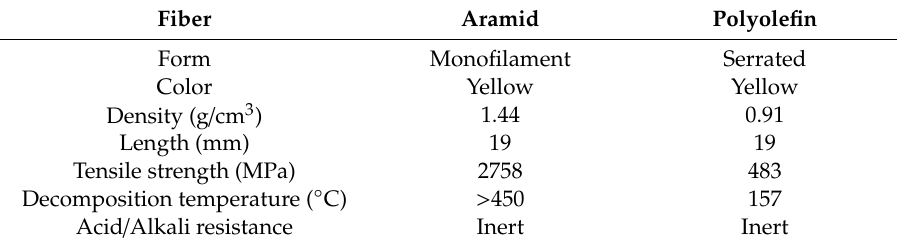
Table 4. Characteristics and properties of polyolefin–aramid (Pol-Aram)